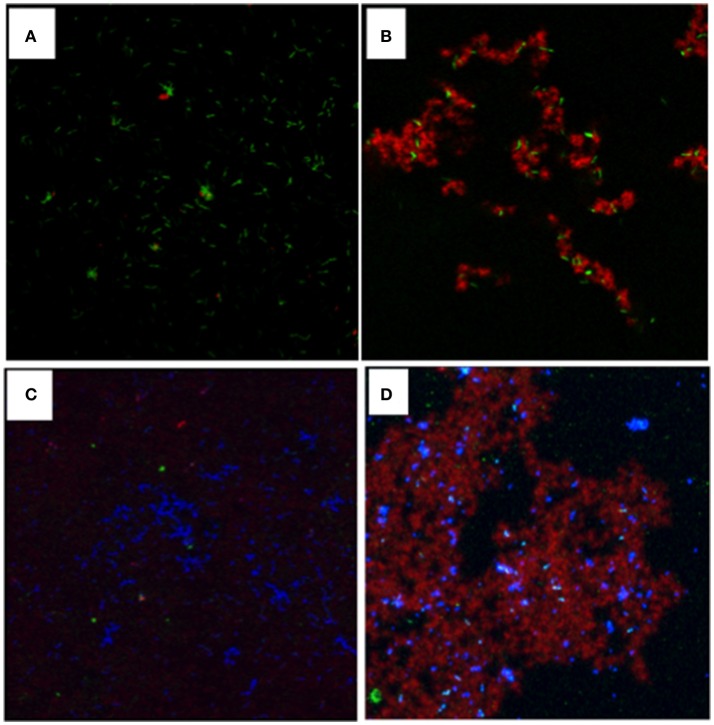
Visualization of glucans synthesized in situ by GtfB adsorbed on L. casei and S. mutans binding to L. casei with and without glucans. For glucan visualization, L. casei was incubated with GtfB or buffer, and following washes, exposed to sucrose for 1 h, and glucans were imaged using a confocal microscope. (A)
L. casei cells (in green) with GtfB incubated in buffer alone; (B)
L. casei with bound-GtfB incubated with sucrose showing rich glucans (in red) engulfed in green L. casei cells. For interactions, S. mutans were mixed proportionally with L. casei with and without GtfB glucan-coating. (C)
S. mutans (in blue) incubated with green L. casei with no glucans on surface; and (D)
S. mutans (in blue) incubated with L. casei coated with GtfB glucans (in red). Images were obtained using an upright Olympus confocal microscope with a 100x oil objective.